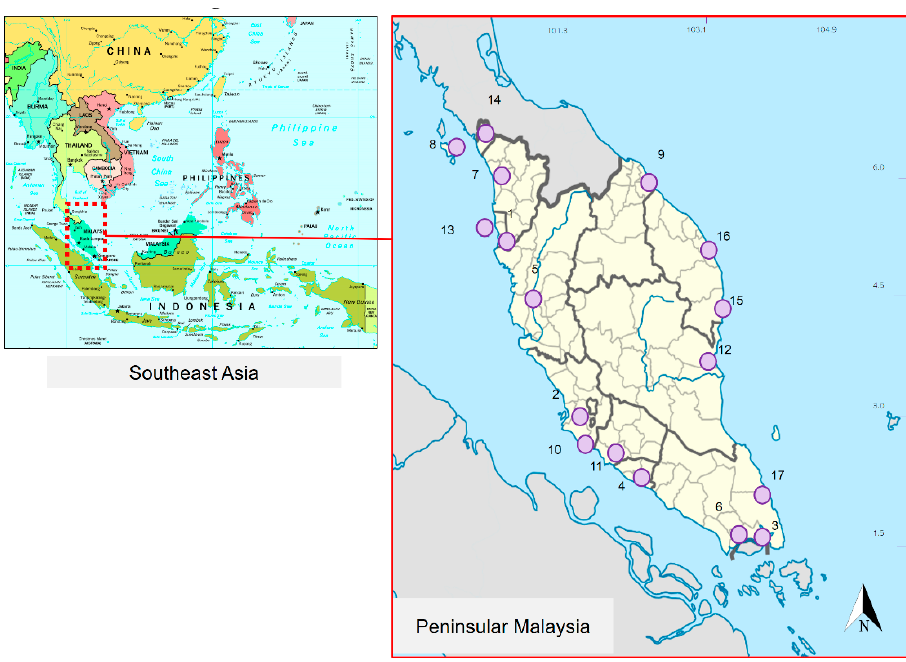
Figure 4 . The geographic locations of the wind stations. Figure 4. The geographic locations of the wind